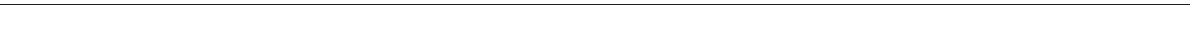
Fig. 5 Association between local T-cell in fi ltration and activation/proliferation and survival in NSCLC patients not treated with immune checkpoint blockade. a Immuno fl uorescent staining of a lung tumor with low ( a ) and high ( b ) T-cell activation/proliferation. Slides were simultaneously stained with a multiplex QIF panel containing CD3 (red), Ki-67 (green), GZB (white), DAPI (blue), and cytokeratin (yellow). Bar = 100 μ m. b Distribution of in situ CD3 (red, left Y axis), T-cell GZB (magenta, right Y axis) and T-cell Ki-67 signal (green, right Y axis) in lung tumors from patients not receiving immune checkpoint blockers. c Association between the level of T-cell GZB and T-cell Ki-67 in the cohort. R = Spearman ’ s correlation coef fi cient. The P value for the correlation is indicated within each chart. d Kaplan – Meier graphical analysis of 5-year overall survival of NSCLC cases not treated with immune checkpoint blockers according to their TIL activation subtypes. A type 1 TIL pattern was with low CD3, a type 2 pattern with high CD3 but low T-cell GZB/ Ki-6; and a type 3 TIL phenotype with high CD3 and elevated T-cell GZB/Ki-67. The number of cases in each group and the log-rank P value is indicated in the